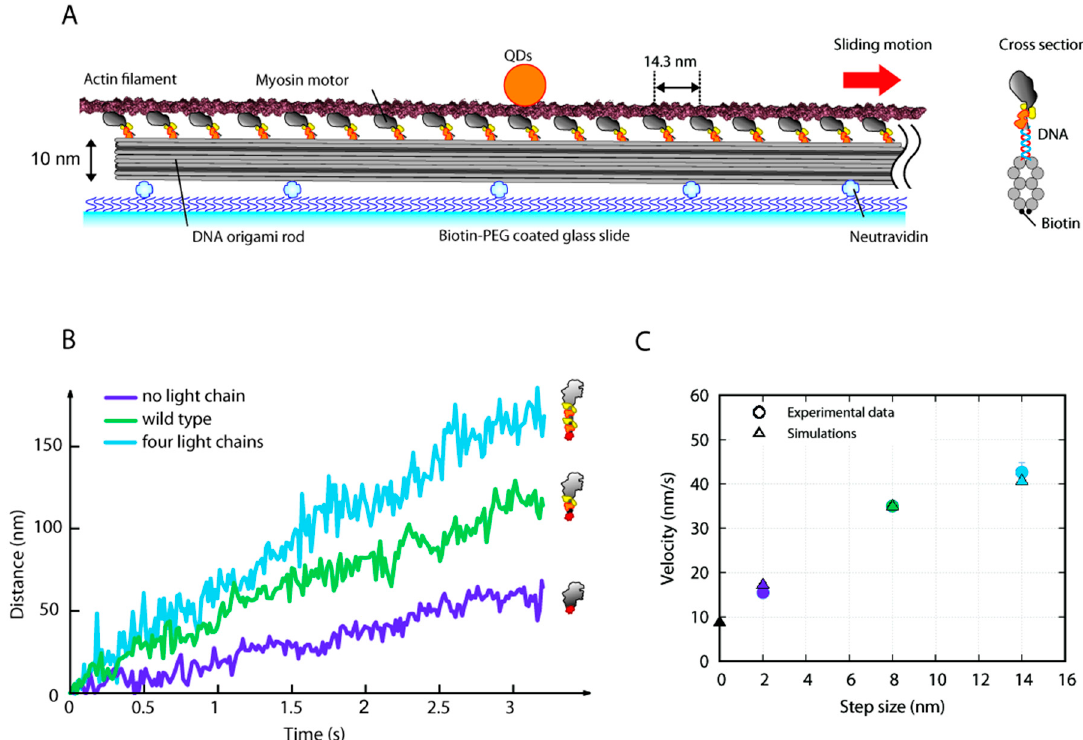
Figure 4. In vitro actin sliding assay driven by a DNA rod-myosin complex. ( A ) Schematic of the in vitro sliding assay. Qdots (QDs) were attached to an actin filament, and a DNA rod-myosin complex was adsorbed onto a glass slide. Biotins were attached to the bottom of the DNA rod to fix the rod to the neutravidin-coated glass slide, and DNA handles (21-base single-stranded DNA) were attached to the top of the DNA rod (see cross section shown in right cartoon) at 14.3 nm spacing along the DNA rod. Because anti-handles were labeled to myosins, the myosins were precisely positioned to the DNA rods with a spacing of 14.3 nm. ATP concentration, 0.5 µM. ( B ) Trajectories of the actin sliding distance for three distinct myosin mutants. Purple—no light chains (without lever-arm); green—WT; blue—four light chains (double-length lever-arm). ( C ) Predicted average velocities of the sliding model (triangles) at different step sizes and the corresponding velocities observed experimentally (dots, colors as in panel B) are related to different lengths of the lever-arm. The intercept at zero step-size is predicted by the model preventing the motor to swing the lever-arm. Experimental data were obtained from at least 12 independent experiments and n = 83, 77, and 72 filaments for no light chain, wild type, and four light chains myosin, respectively. Error bars indicate standard errors.